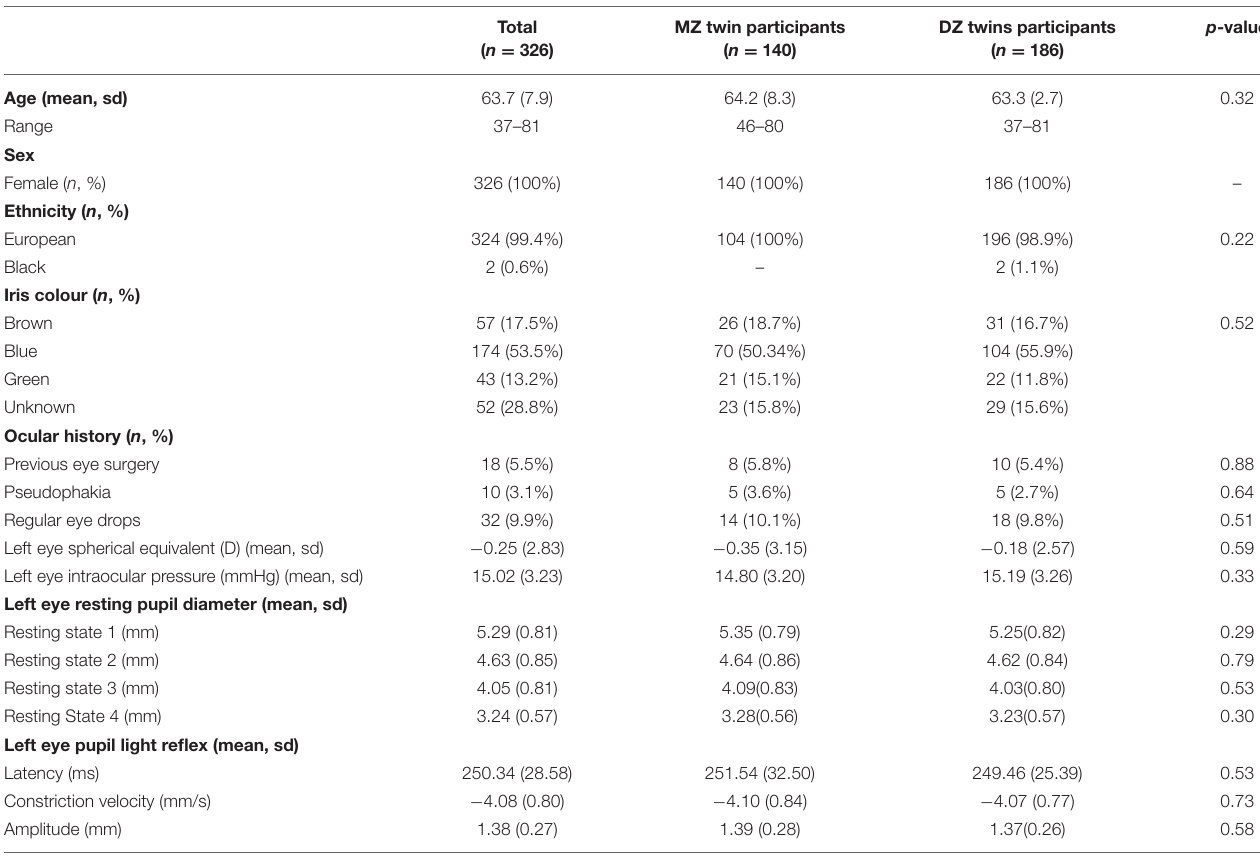
TABLE 1 | Full demographic details and left eye pupil measurements of all twin